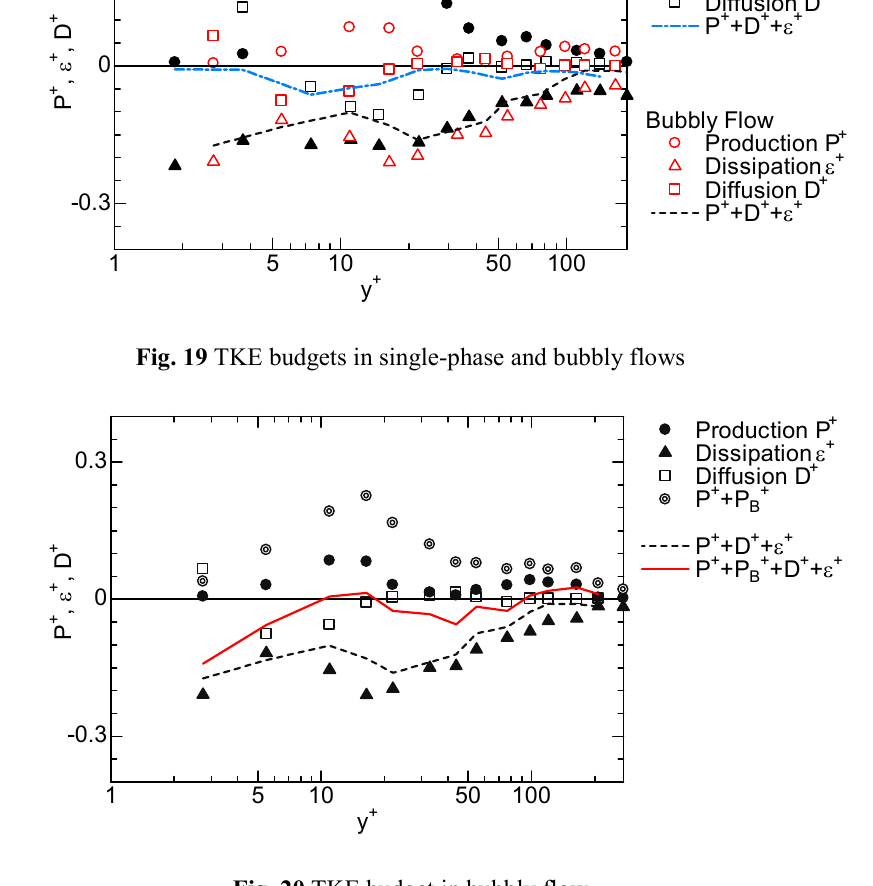
Fig. 20 TKE budget in bubbly